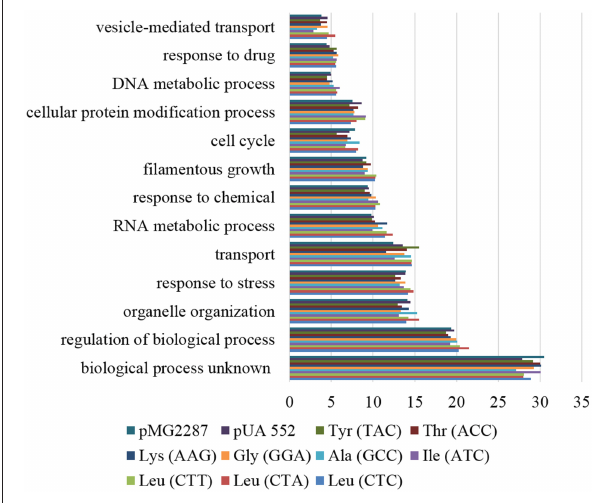
identified in the evolved strains, relative to non-evolved strains. The graph represents the percentage of genes affected in each process above